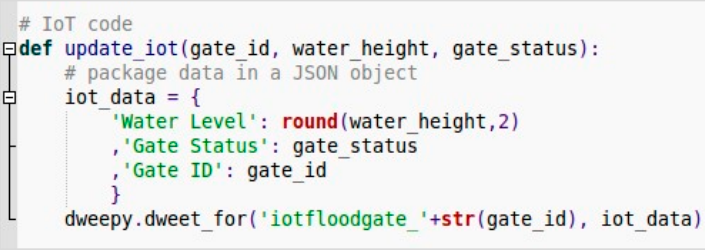
Figure 13. Code Excerpts: using open-source IoT libraries and services, such as Dweet.io.